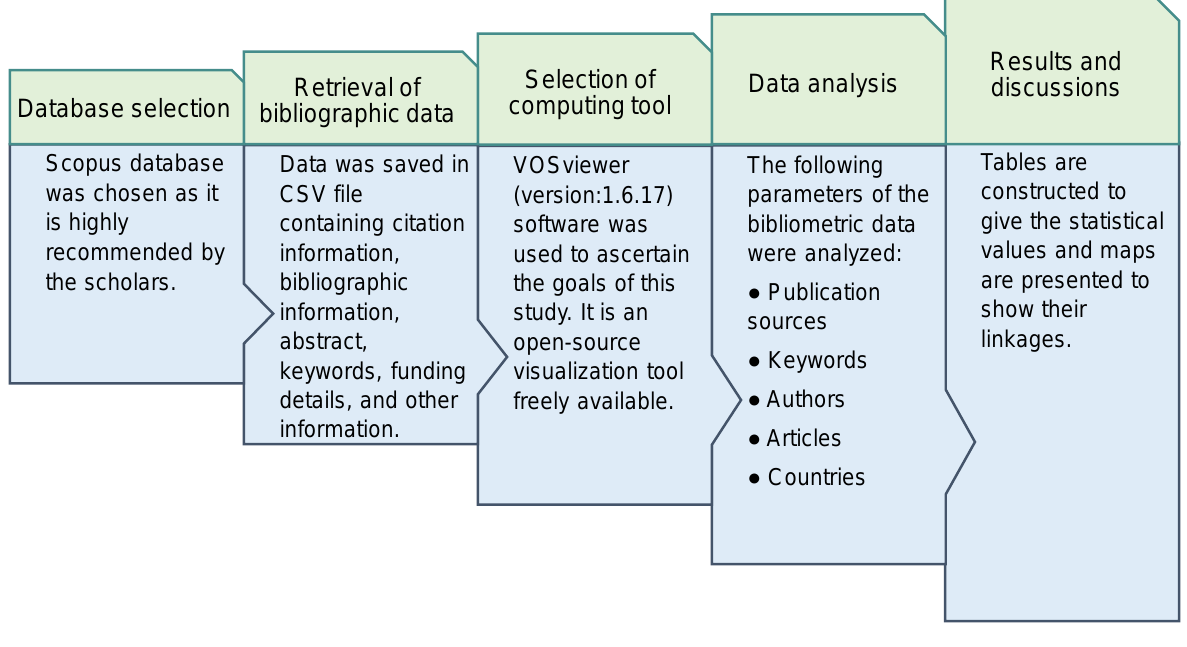
Figure 2. Flowchart of the analysis procedure.